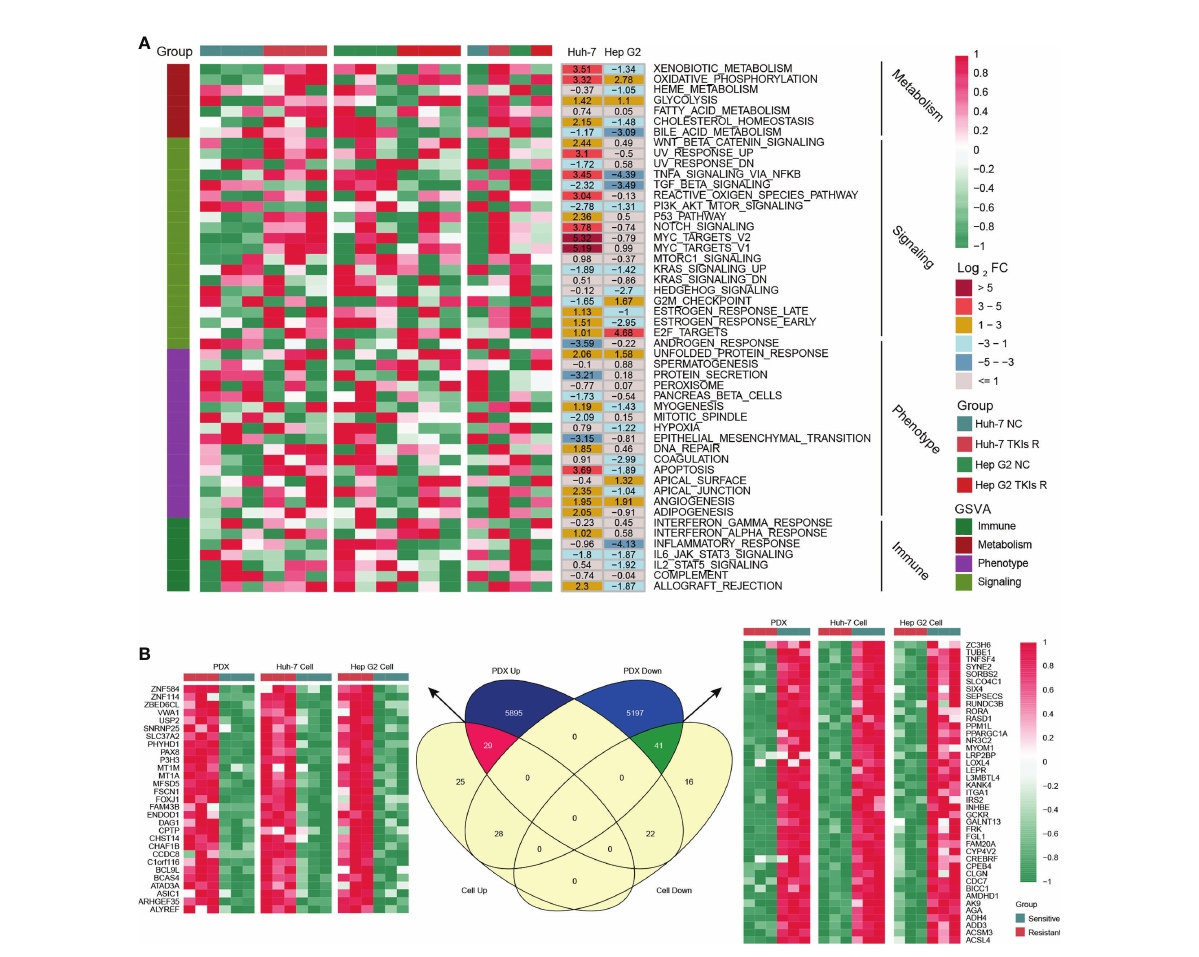
FIGURE 2 Generation of the MDH gene signatures. (A) GSEA enrichment analysis of differentially expressed genes (DEGs) between parental HCC cells and corresponding sorafenib-resistant HCC cells. (B) Venn diagram of MDH gene signatures acquired from the sorafenib-resistant PDX model and HCC cell